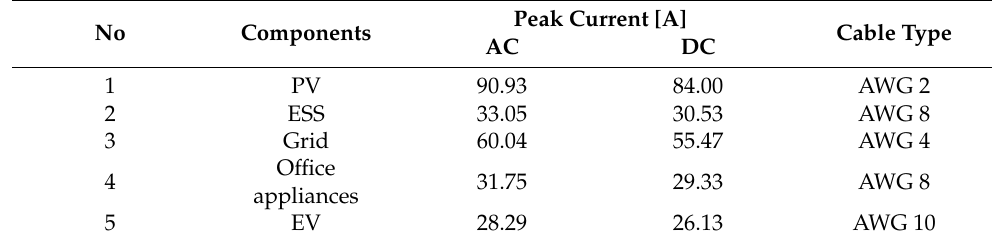
Table A1. Cable types.